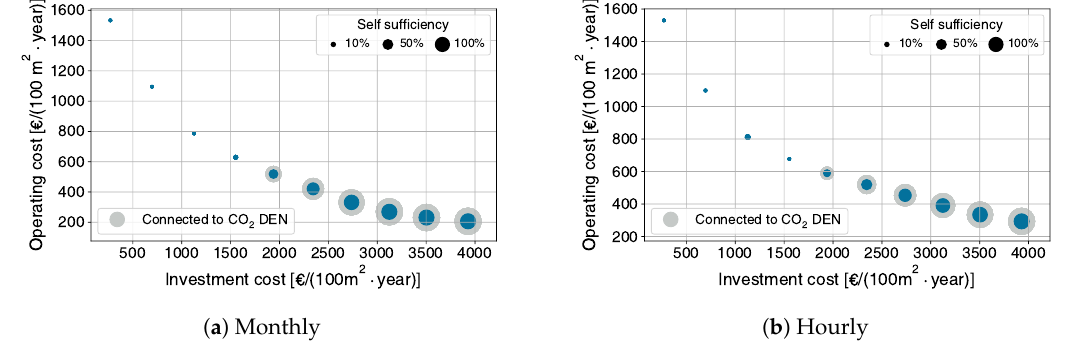
Figure 13. Pareto Geneva city center different time